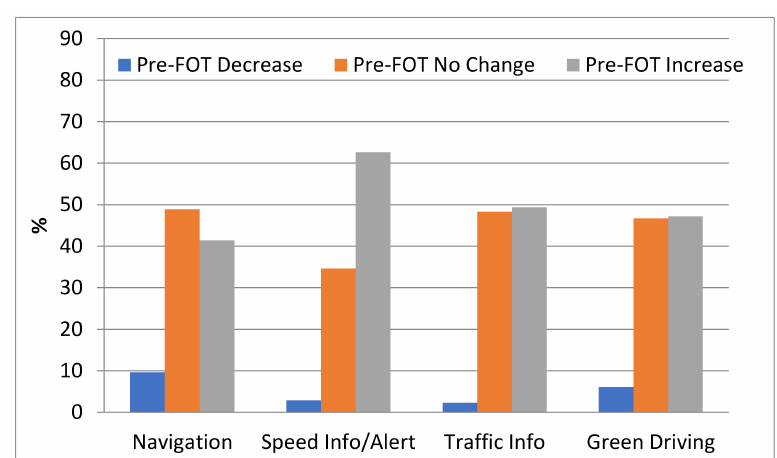
Figure 5. Pre-FOT: expected safety impact per function.